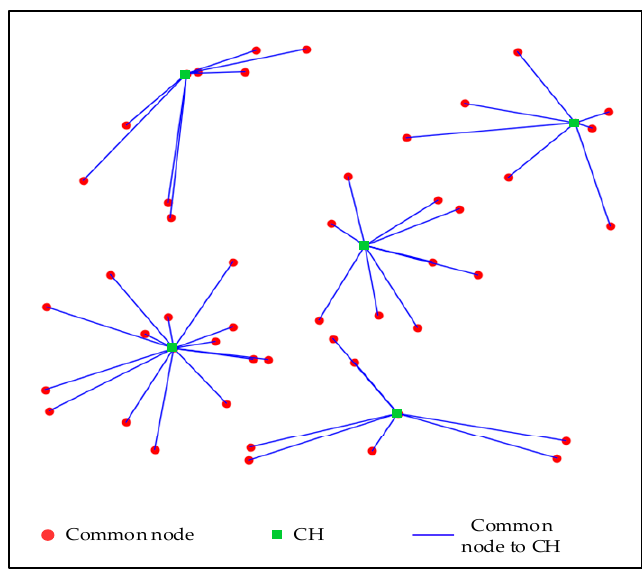
Figure 3. Cluster result of affinity propagation-based self-adaptive (APSA) algorithm (50 sensors).